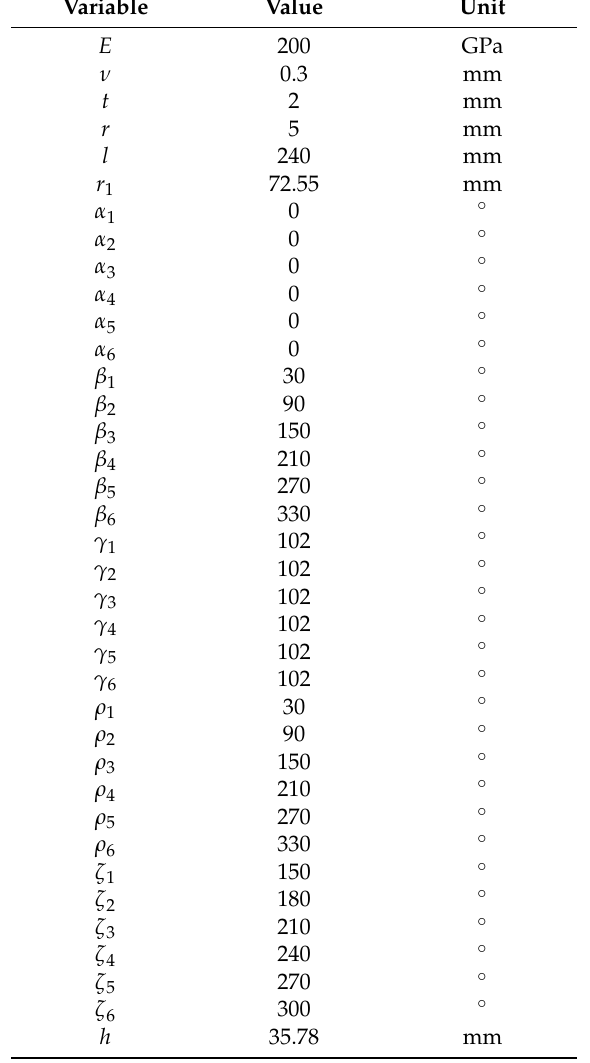
Table 1. Parameters of the 6-DOF